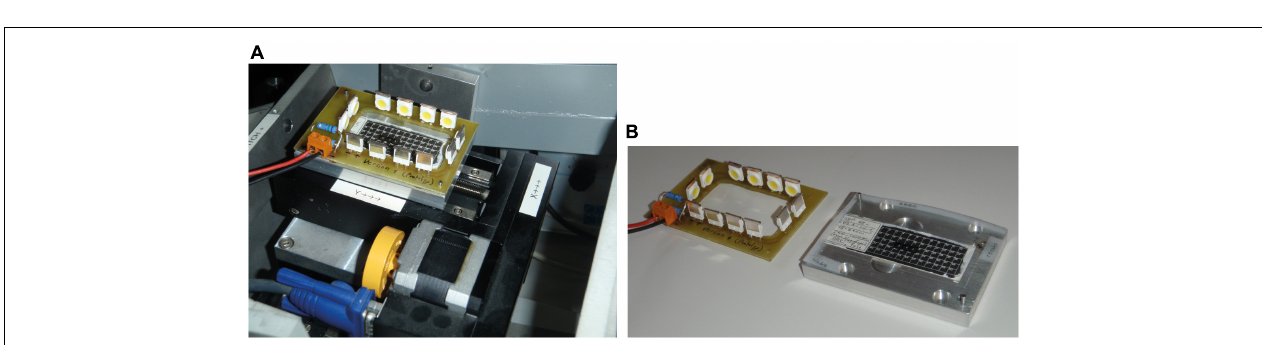
FIGURE 10 | The user interface of the program AMOR v. 4.2 in manual mode. Boxes showing a number are numeric input controls or output indicators and are scriptable. Buttons are functions and are also scriptable.